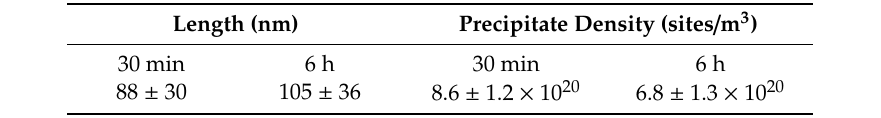
Table 4. θ (cid:48) -Al 2 Cu precipitate size and number density evolutions for di ff erent aging conditions at 190 ◦ C for the AlSi7Cu3.5Mg0.15 (Mn, Zr, V) alloy. Table 4. θ′-Al 2 Cu precipitate size and number density evolutions for different aging conditions at 190 °C for the AlSi7Cu3.5Mg0.15 (Mn, Zr, V) alloy.